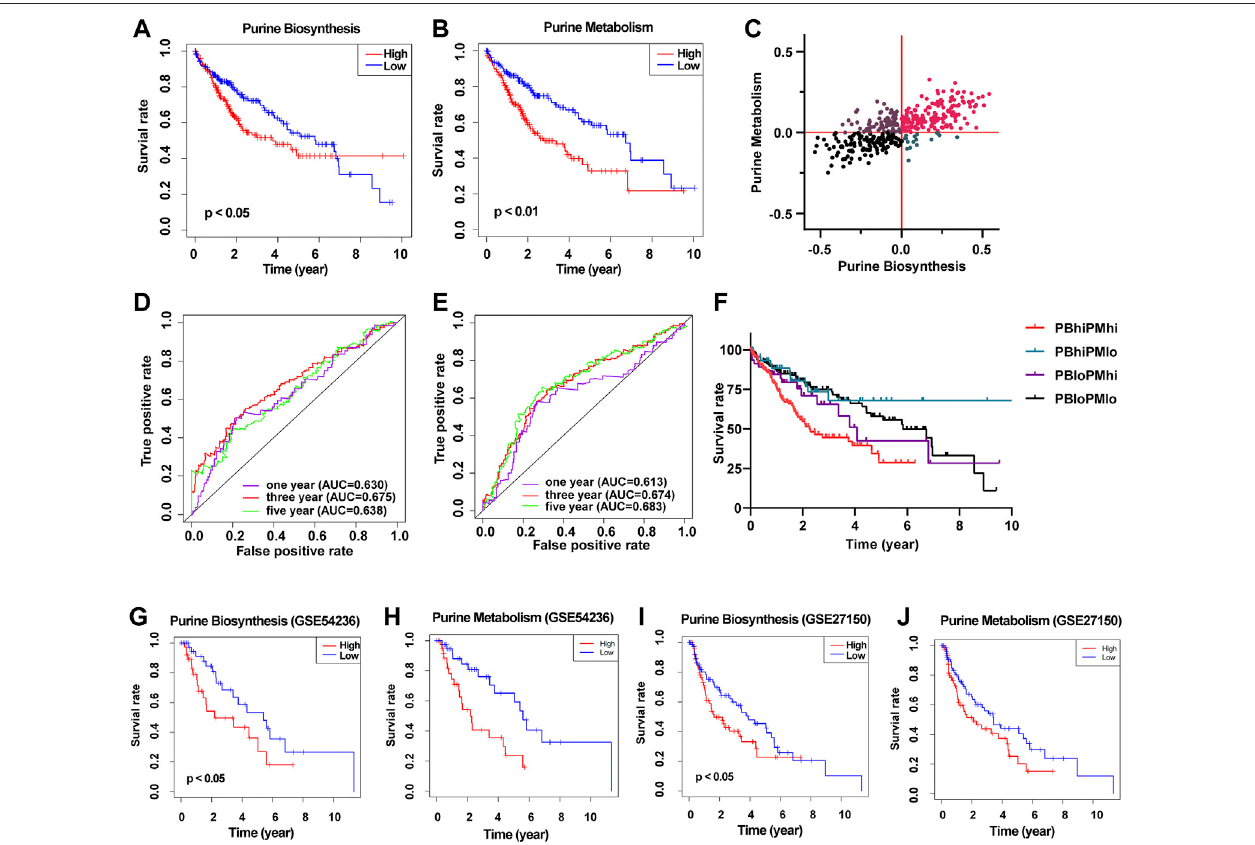
FIGURE 2 | Construct a prognostic model of purine-related metabolic pathway in patients with HCC. (A) Survival curve showed the relationship between the activityofpurinemetabolismpathwayandtheprognosisofHCC; (B) survivalcurveshowedtherelationshipbetweenpurinebiosynthesispathwayactivityandprognosis of HCC; (C) scatter plot shows the purine metabolic pathway activity and purine synthesis pathway activity of each patient with HCC and are divided into four groups according to the median of the two groups; (D) ROC curve shows the accuracy of predicting the prognosis of HCC according to the activity of purine metabolic pathway; (E) ROC curve shows the accuracy of predicting the prognosis of HCC according to the activity of purine synthesis pathway; (F) survival curve shows the prognosisofpatientswithHCCindifferentgroups; (G) survivalcurveshowedtherelationshipbetweentheactivityofpurinesynthesispathwayandtheprognosisofHCC (GSE54236); (H) survival curve showed the relationship between purine metabolism pathway activity and prognosis of HCC (GSE54236); (I) survival curve showed the relationship between the activity of purine synthesis pathway and the prognosis of HCC (GSE27150); (J) survival curve showed the relationship between the activity of purine metabolism pathway and the prognosis of HCC